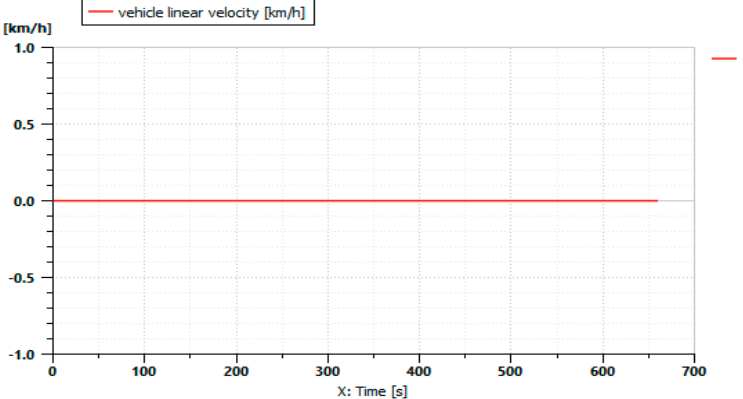
Figure 23. Tractor driving cycle with a straw tub grinder attached.